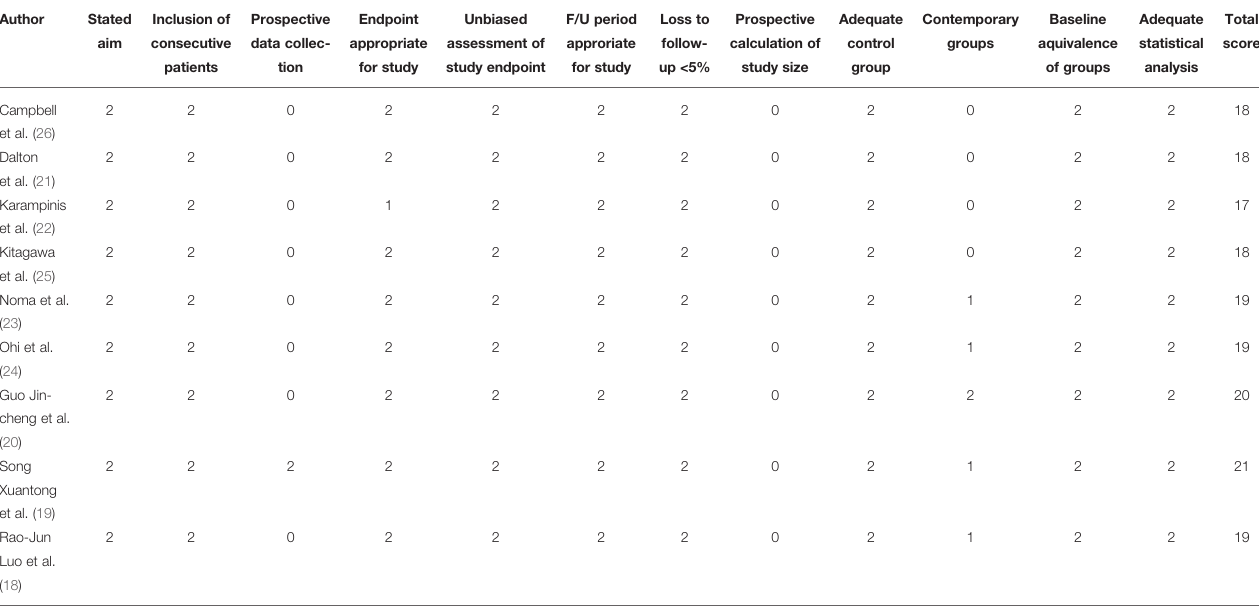
TABLE 2 | Quality assessment by methodological index for non-randomized studies tool.